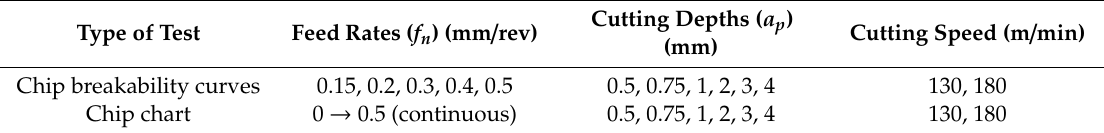
Table 2. The cutting data used for chip breakability curves and chip